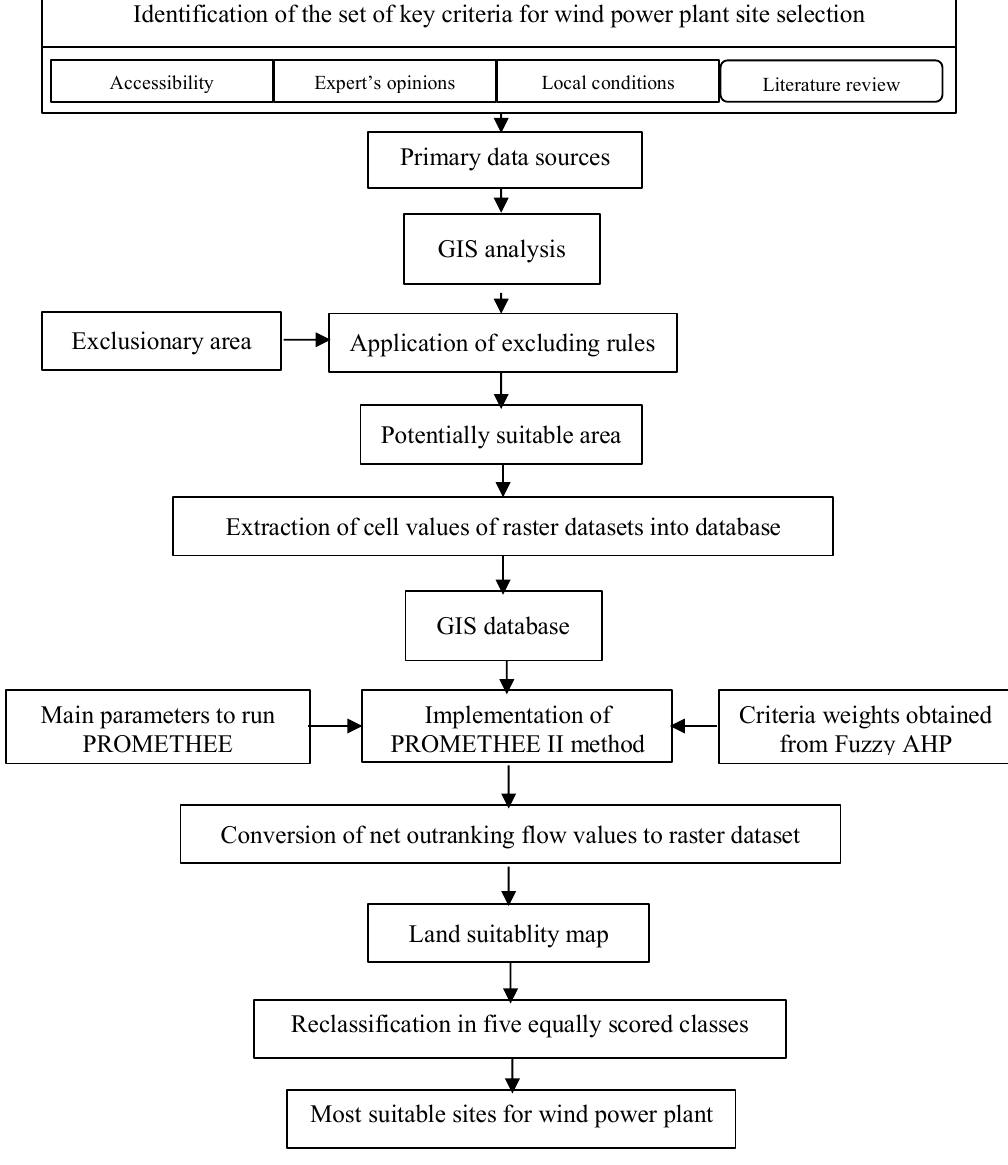
Figure 2. The process of the wind power plant site selection in proposed